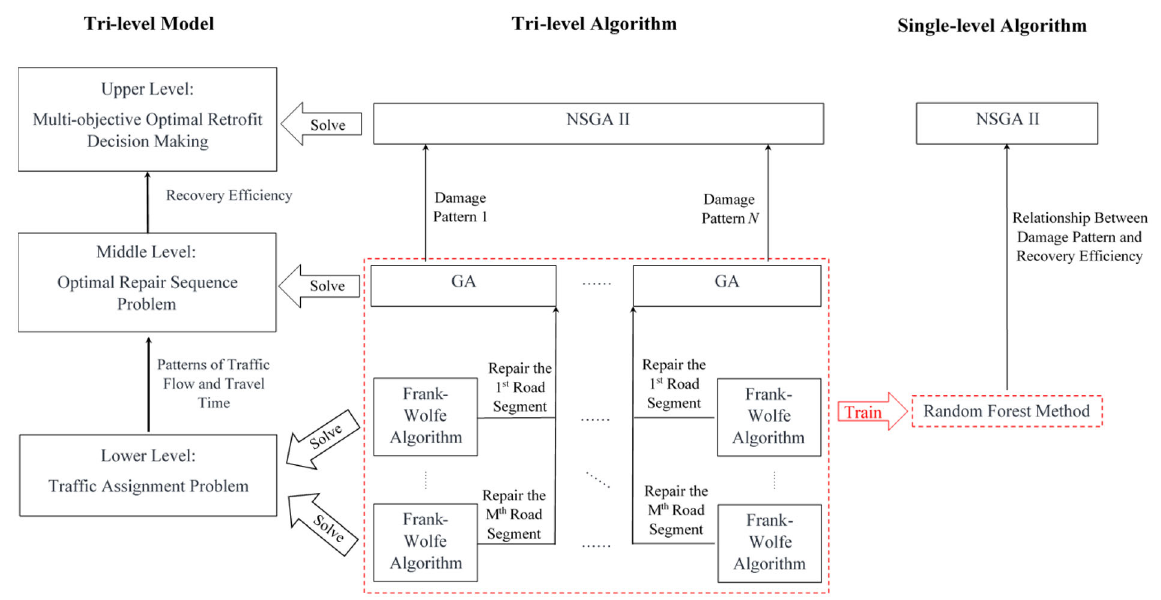
Fig. 5 Structure of the trilevel algorithm and the single-level